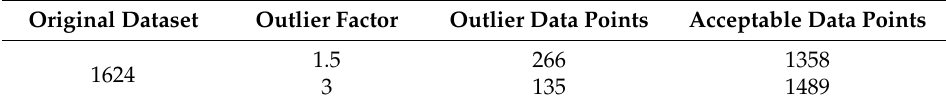
Table 4. Optimal interquartile range outlier